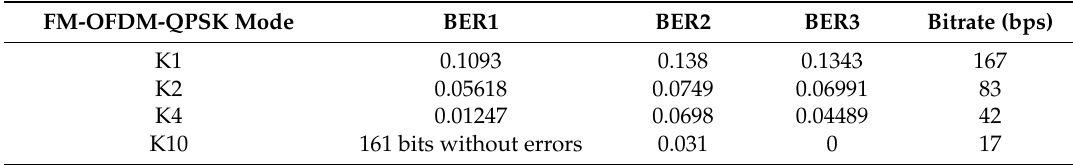
Table 3. Results of decoding of FM-OFDM-QPSK signals, recorded during sea trials on the distance of 25 km.